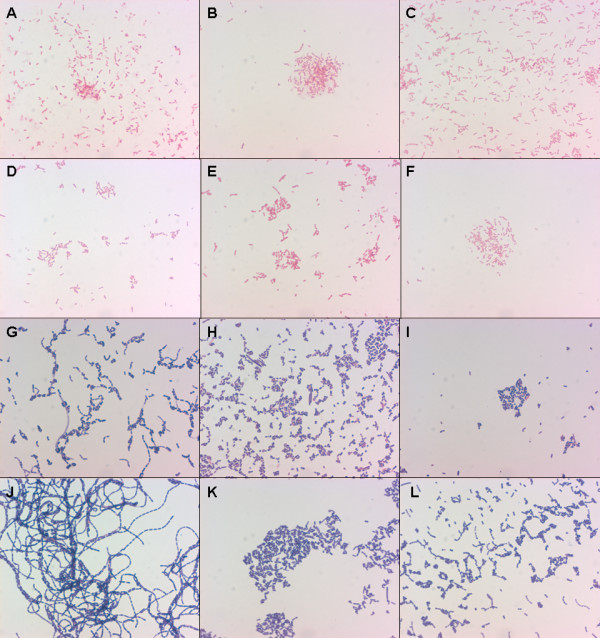
Microscopic images (100 ×) of Gram stains of L. iners and L. gasseri. A-F: L. iners; A: BVS11, B: FB04-04, C: FB06-01, D: FB17-07, E: FB94-05b and F: FB30-01AN; G-L: L. gasseri: FB02-02, H: FB33-01, I: FB34-01AN, J: FB89-3, K: FB103-2, L: PB88-T2-1.